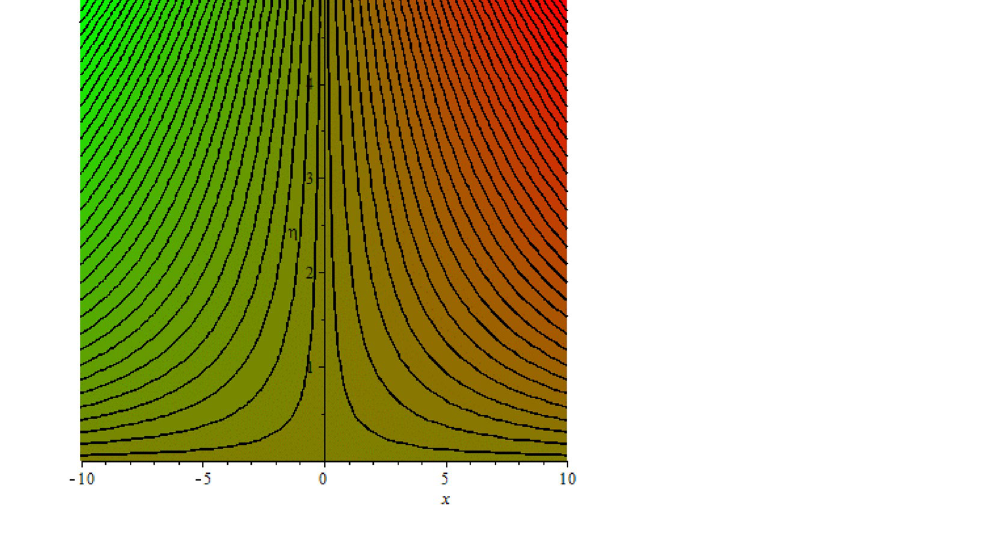
Figure 9. Stream lines when γ = 0.0 and A = 1.0.